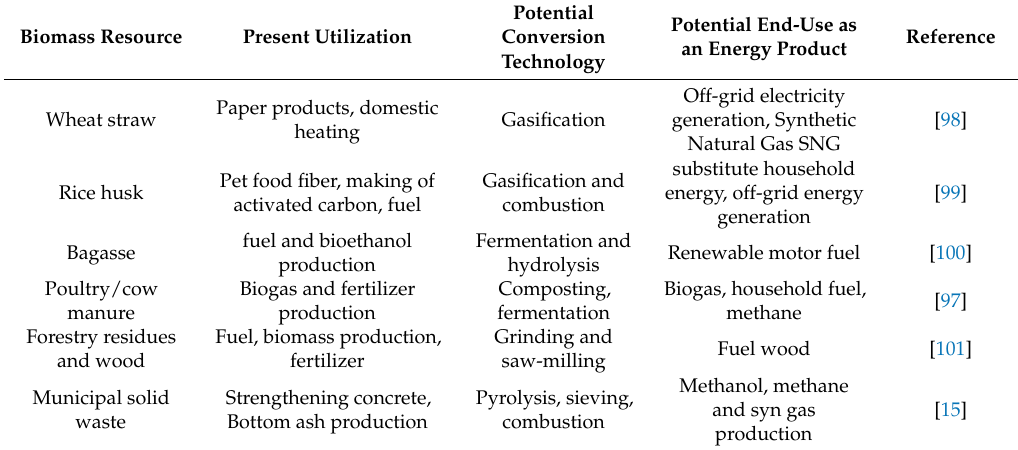
Table 14. Biomass resources, their possible utilization, and technologies for conversions.